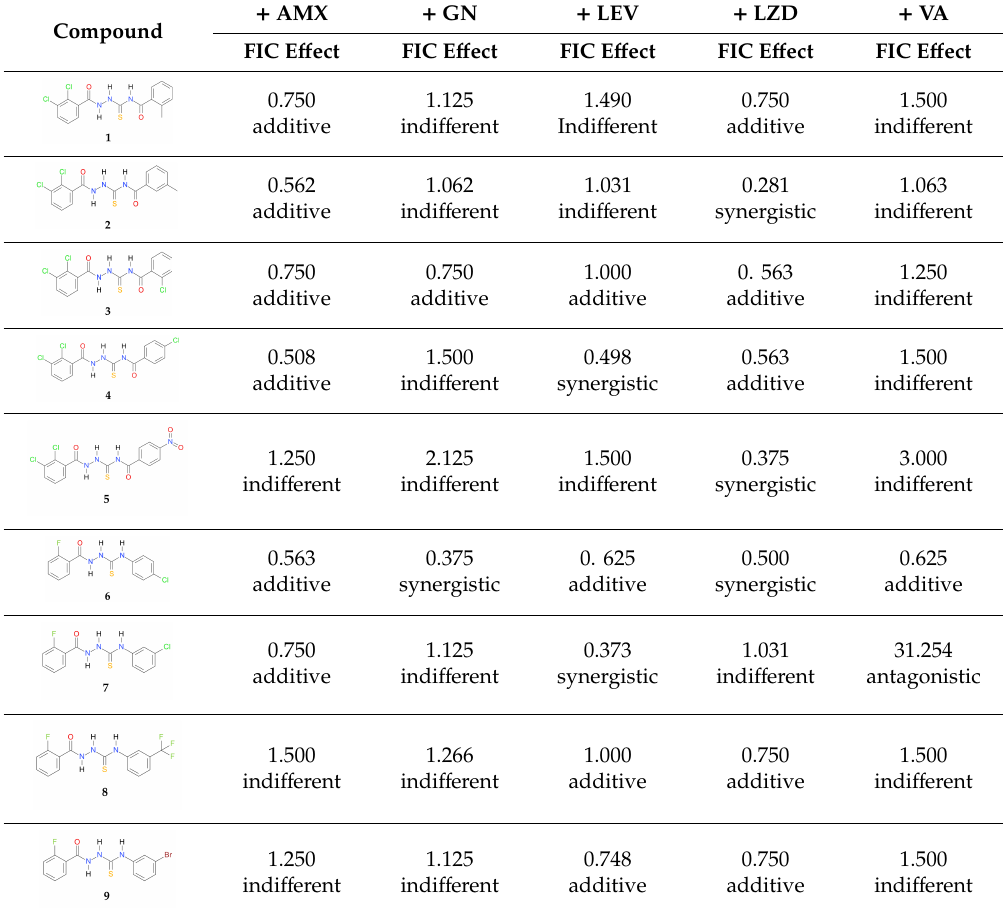
Table 3. In vitro evaluation of antibacterial